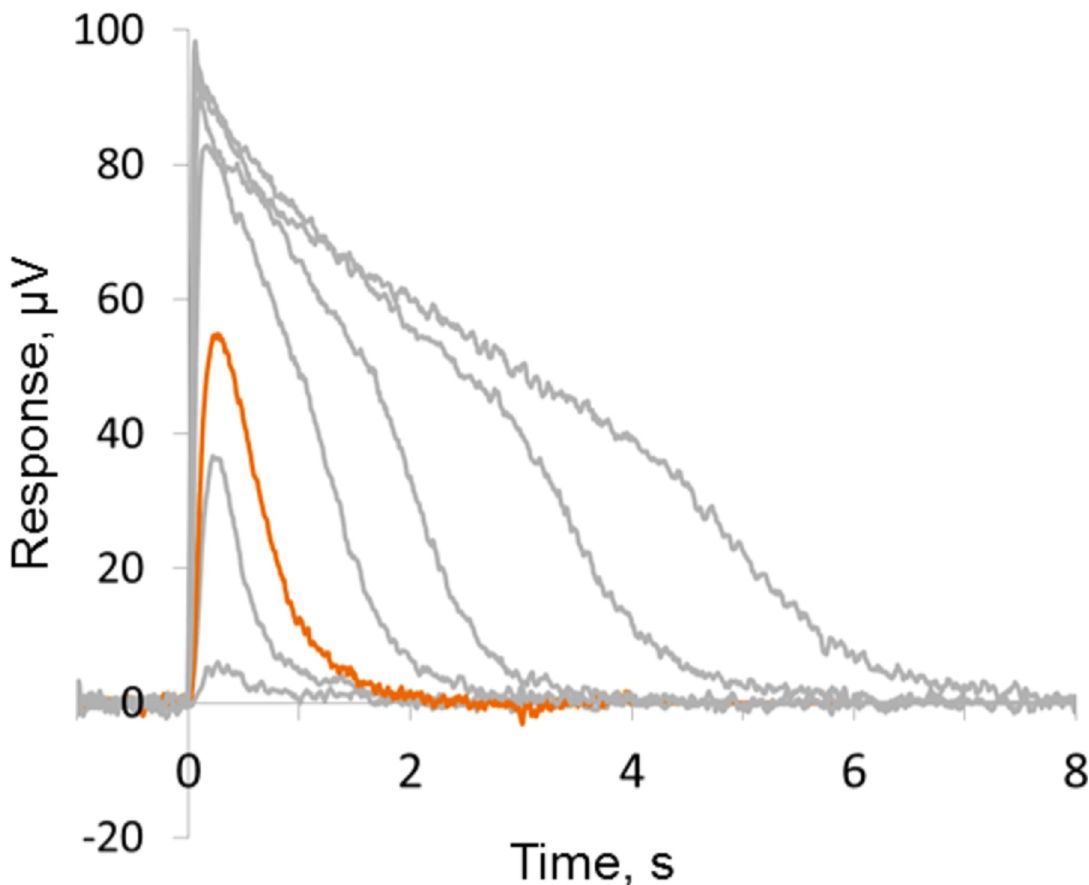
Fig 2. Typical set of photoreceptor responses of isolated pigeon retina to blue flashes of increasing intensities. Flash duration is 10 ms. The intensities of flashes were 3.7 × 10 6 , 4.67 × 10 7 , 1.17 × 10 8 , 4.17 × 10 8 , 1.32 × 10 9 , 4.36 × 10 9 photons/mm 2 . Red curve indicates approx. half-saturated response (flash 1.17 × 10 8 ) that was selected for further testing with modulated MF inclination.